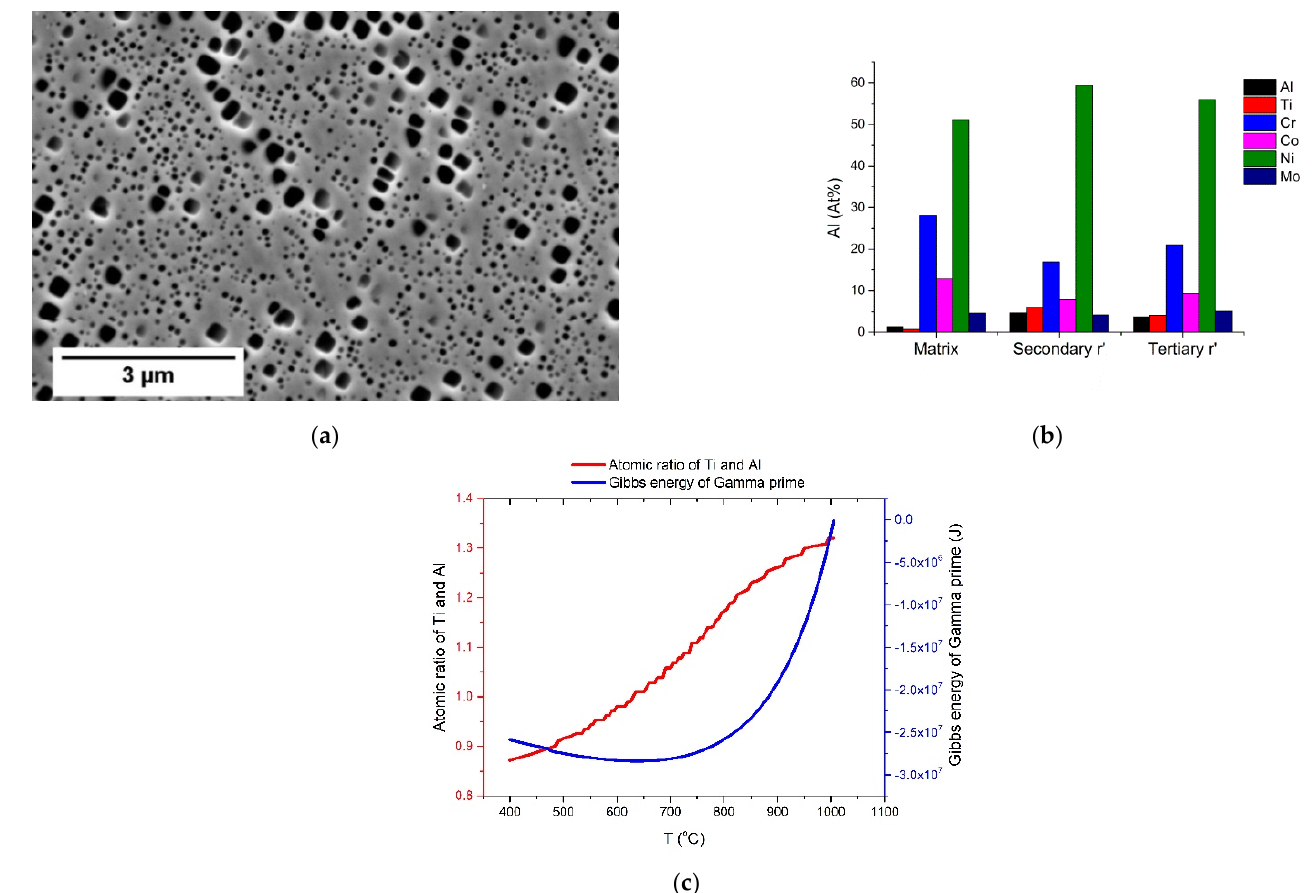
Figure 14. Bimodally distributed γ ’ particles’ diameters: ( a ) a micrograph of the IA1000 sample; ( b ) a quantification plot of composition of two types γ ’ particles; ( c ) a calculated atomic ratio of Ti and Al and Gibbs energy of γ ’ particles.